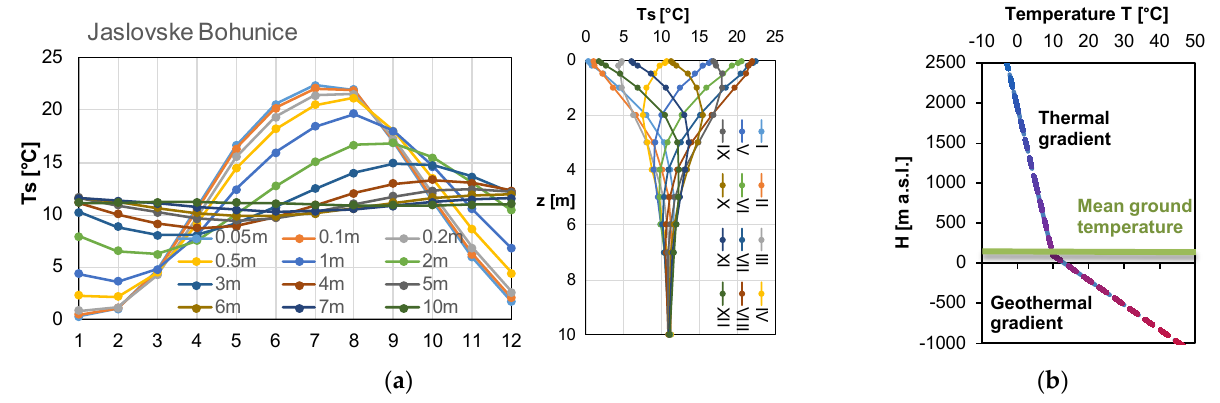
Figure 1. ( a ) Long-term monthly observed temperature ( Ts ) at different depths and the develop- ment of long-term temperature in individual months at different depths ( z ) at Jaslovské Bohunice meteorological station, 1991–2020. ( b ) Scheme of the air thermal gradient and geothermal gradient, Jaslovské Bohunice.